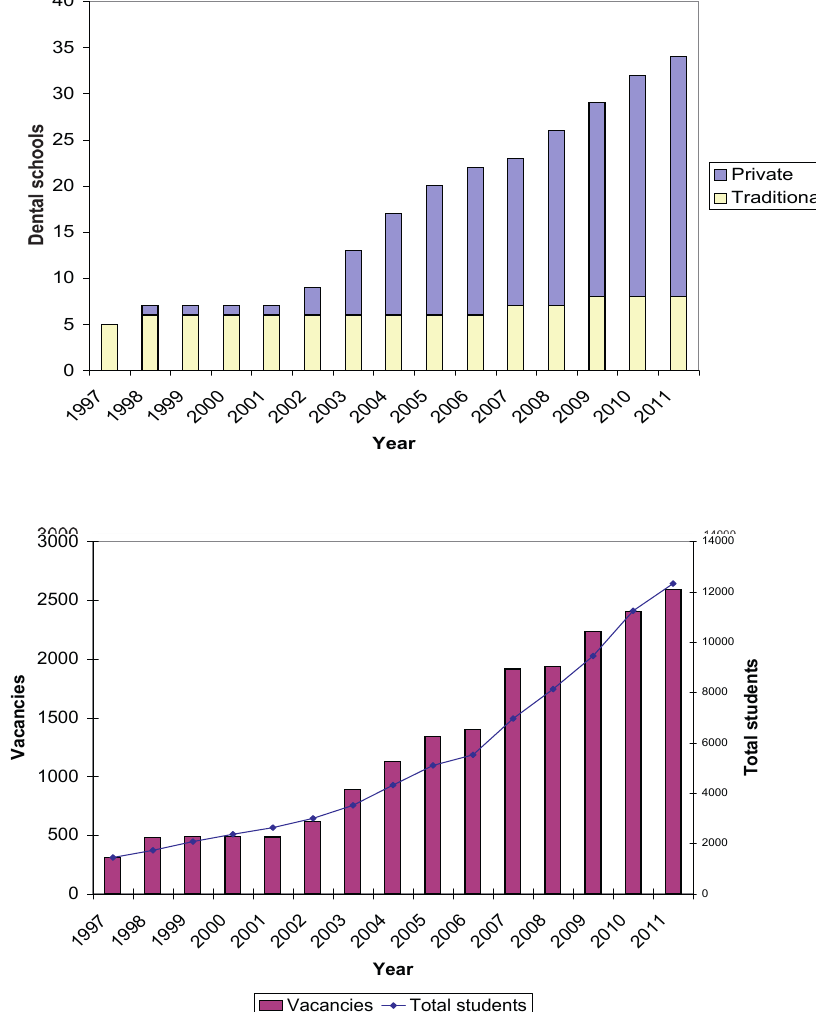
Figure 2 - Number of vacancies and total students at dental schools in Chile,